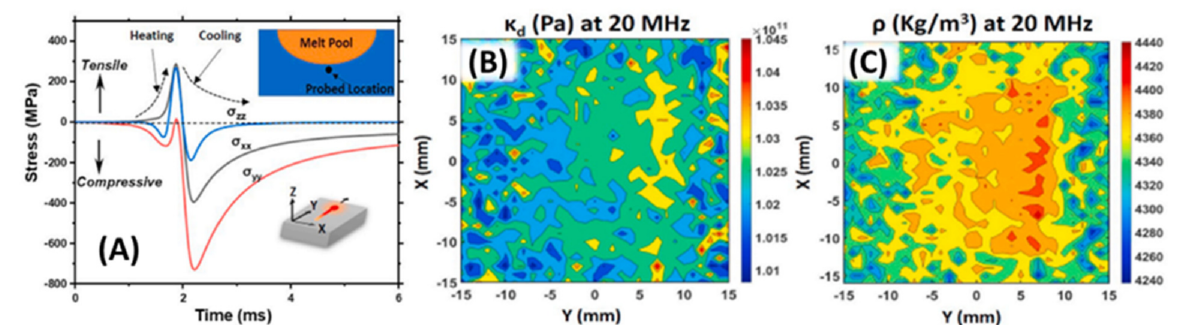
Figure 22. ( A ) Numerical computational results of residual stresses along laser scanning plane and building direction. ( B ) Dynamic bulk modulus elastography on the SLM Ti6Al4V sample along the laser scanning plane. ( C ) Effective density distribution on the SLM Ti6Al4V sample along the laser scanning plane.